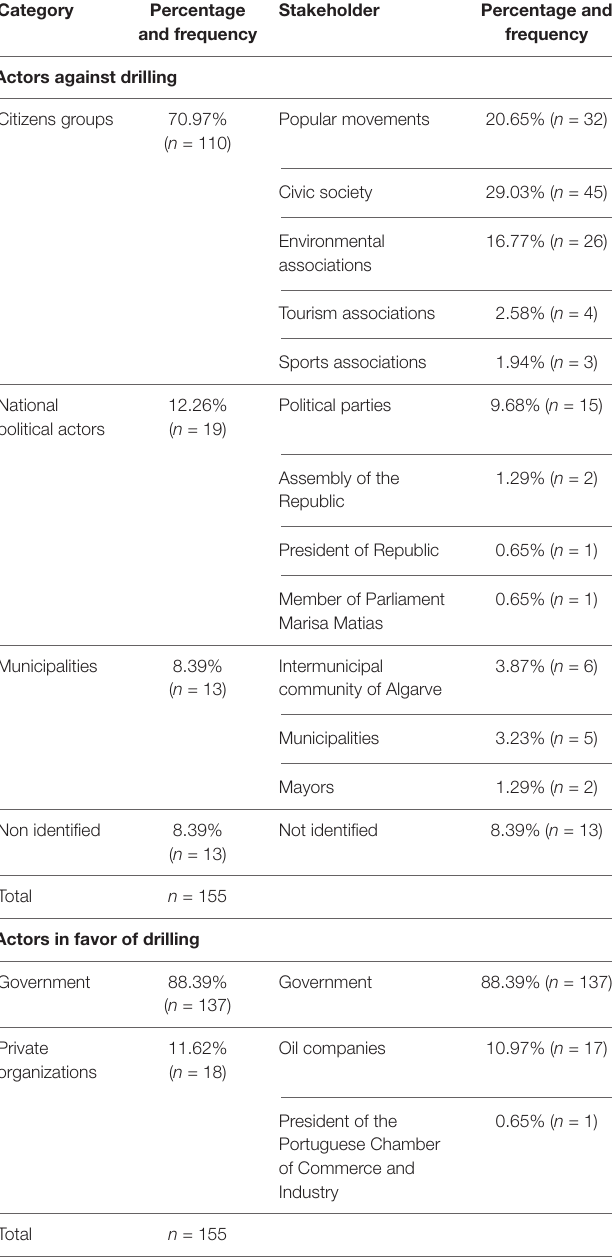
TABLE 1 | Relative frequency of second-order categories and themes in “Público” and “Correio da Manhã,” June 2016 to December 2018.